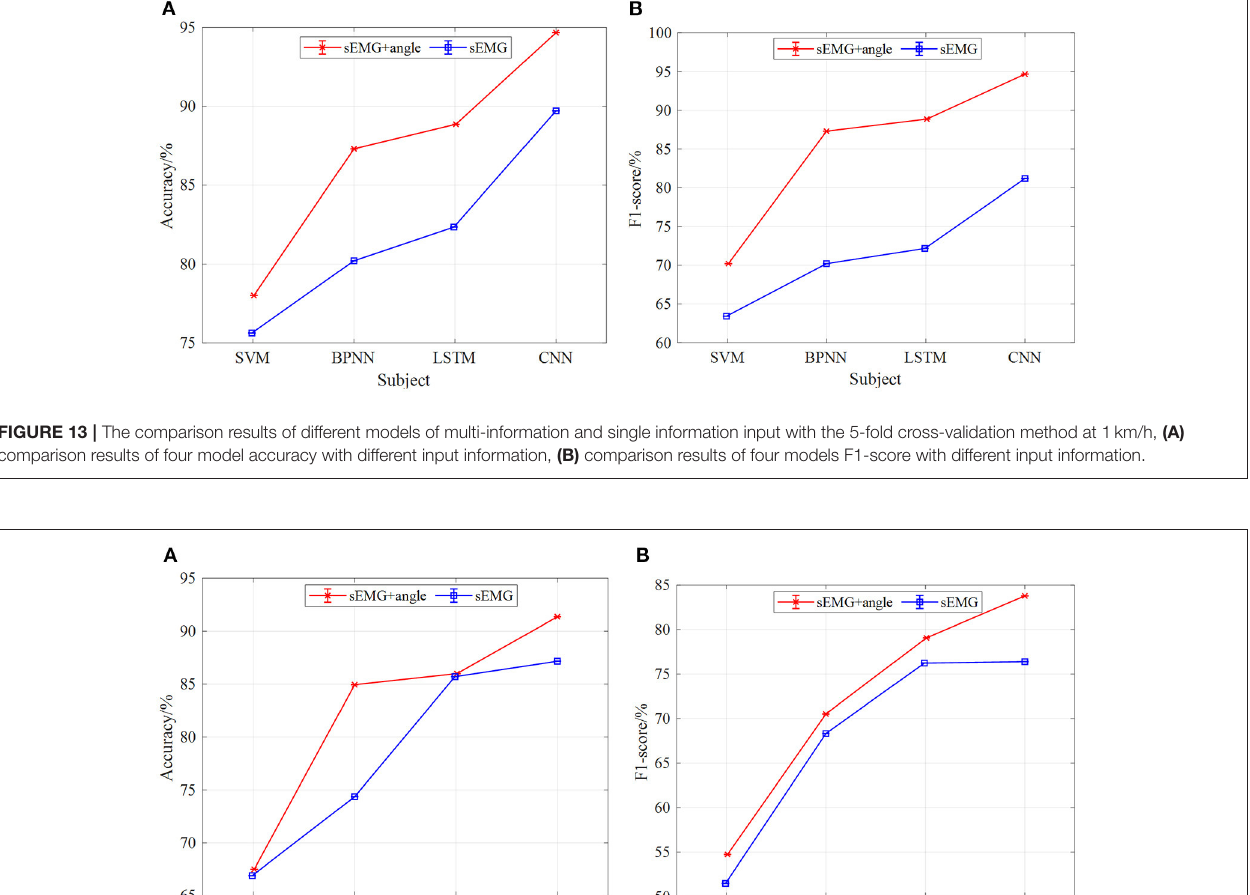
Frontiers in Neurorobotics |